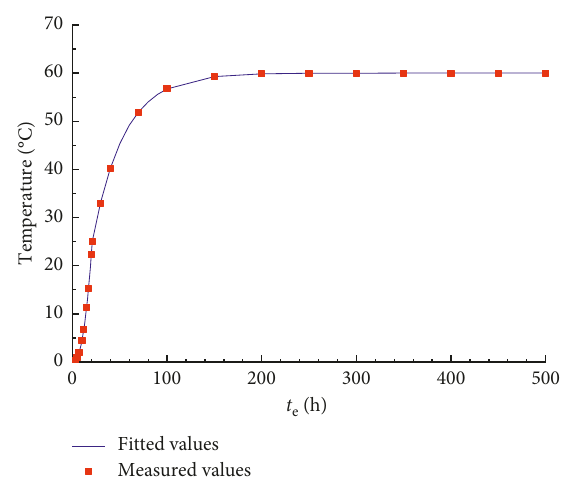
Figure 10: Adiabatic temperature rise test